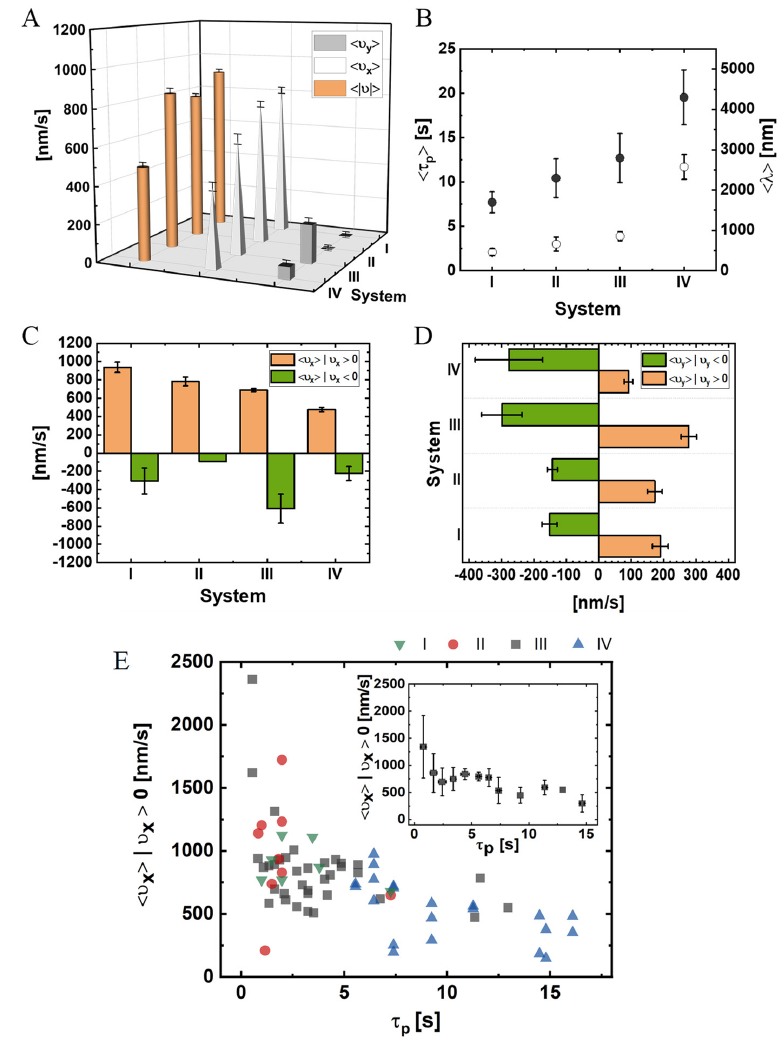
Figure 4. NP experimental mean velocities, run-times, and run-lengths for systems I–IV (data for A–D are provided in Table S1). ( A ) Mean longitudinal, (cid:104) υ x (cid:105) , transverse, (cid:104) υ y (cid:105) , and absolute, (cid:114) (cid:16) (cid:17) (cid:104) υ (cid:105) = υ 2 x + υ 2 y velocities. A minus-end directed motion corresponds to υ x > 0 and a right- handed motion corresponds to υ y > 0 (see Figure 2C for spatial orientation). ( B ) Run-times and run-lengths: the run-time is measured from the time the NP binds to the MT until the time it unbinds from it; the run-length is the accumulated distance traveled along the MT symmetry axis; υ x > 0 and υ x < 0 define minus-end and plus-end directed motion, respectively. ( C ) Mean longitudinal velocity, evaluated separately for minus-end directed and plus-end directed motions. ( D ) Mean transverse velocity, evaluated separately for right-handed and left-handed motions. ( E ) Main panel: (cid:104) υ x (cid:105) | υ x > 0 is plotted against τ p . Each data point corresponds to a specific NP, colors correspond to the experimental system (I–IV). Inset: average values over all NPs, regardless of their associated system. Values indicate mean ± SEM. The mean radius of the bare NP is 20